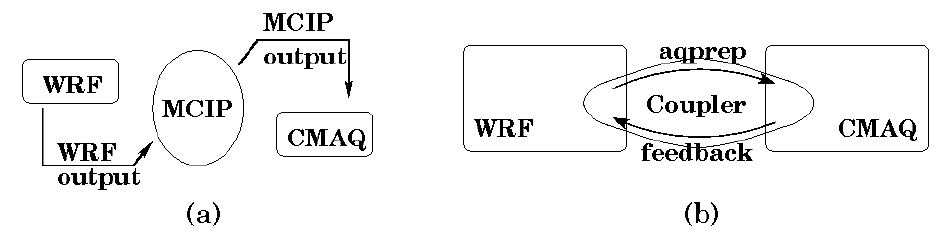
Fig. 1. Schematic of high-level modules in (a) offline WRF-CMAQ system and (b) two-way coupled 2 WRF-CMAQ model. 3